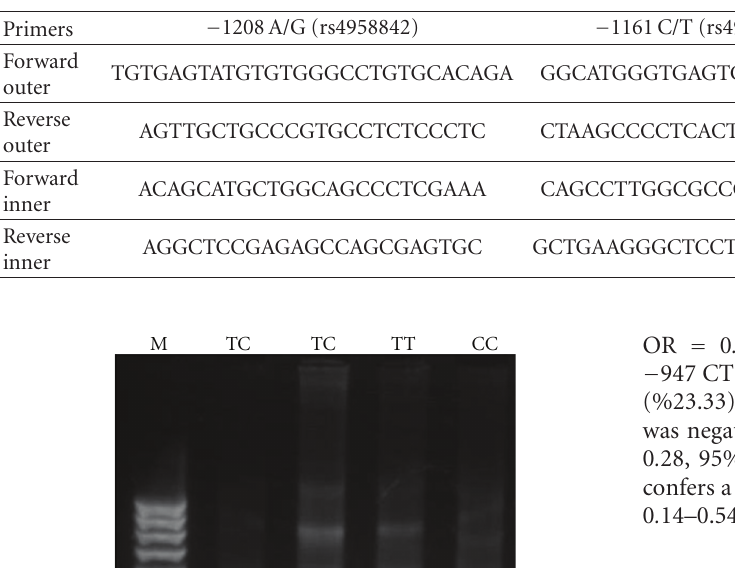
Table 1: Primers used for polymorphism determination.